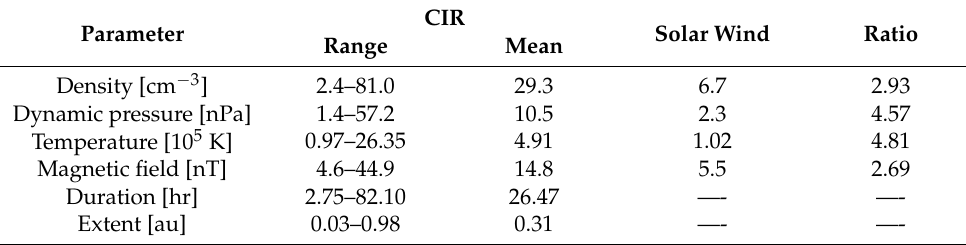
Table 1. Properties CIR and solar wind